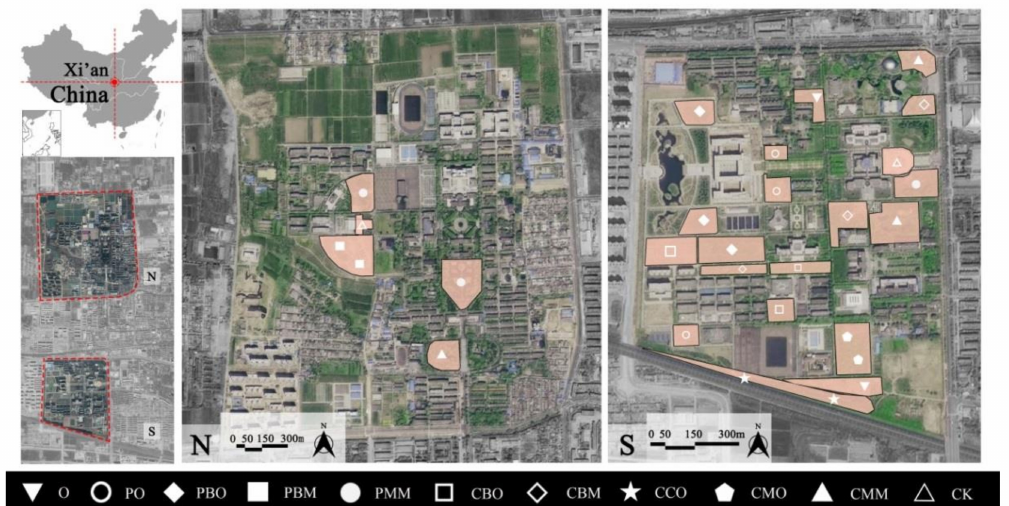
Figure 1. Map showing sampling locations and their repetition.